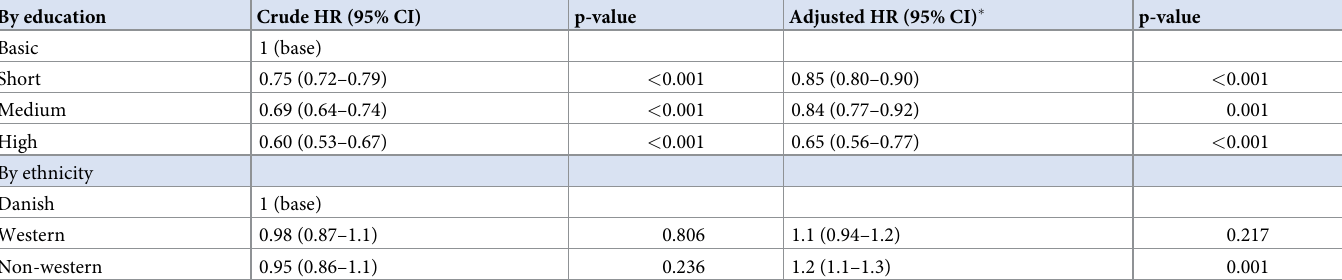
Table 4. Risk of MACE across level of education and ethnicity among 19,383 CR participants assessed by hazard ratios (95% confidence intervals) from Cox-regres- sion models. By